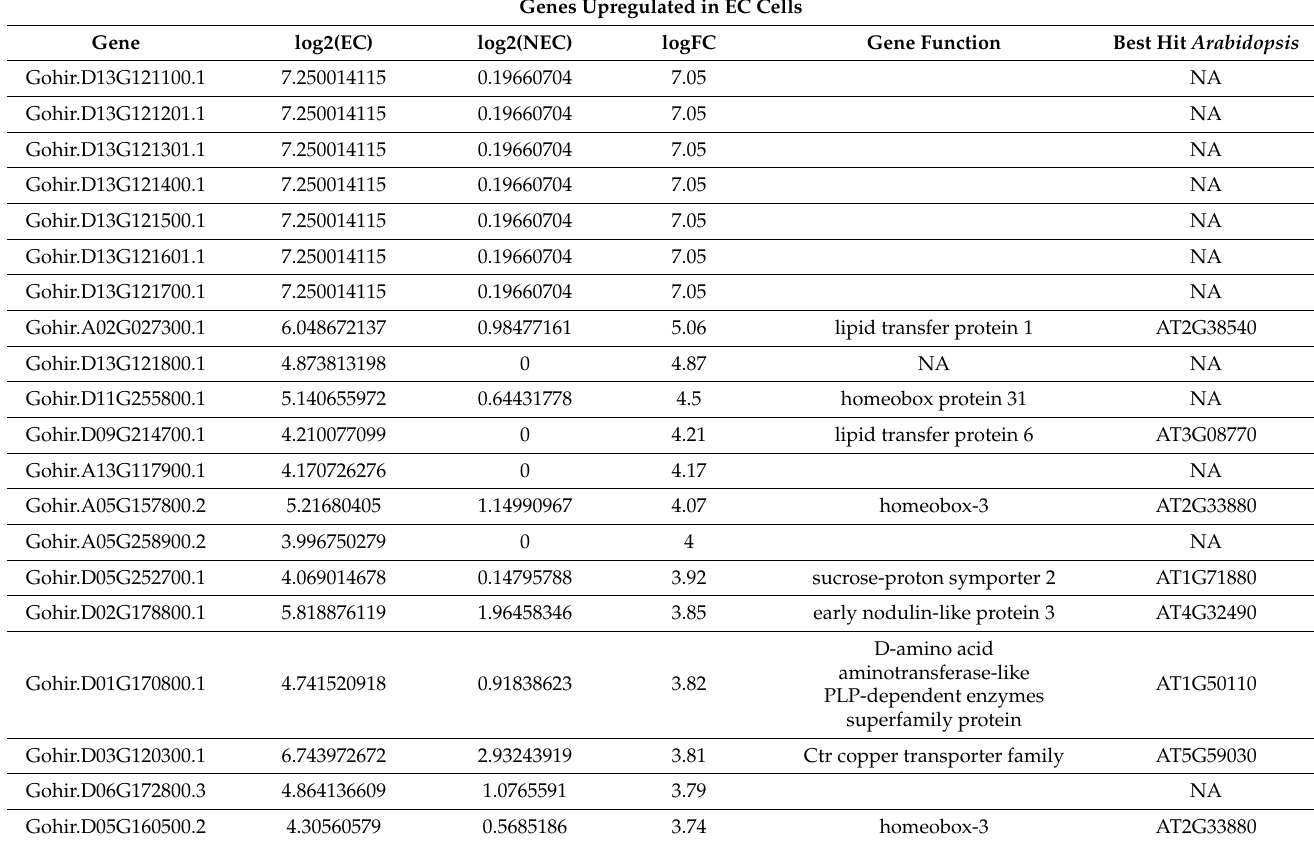
Table 1. Top 20 up-/down-regulated genes in Coker312 EC